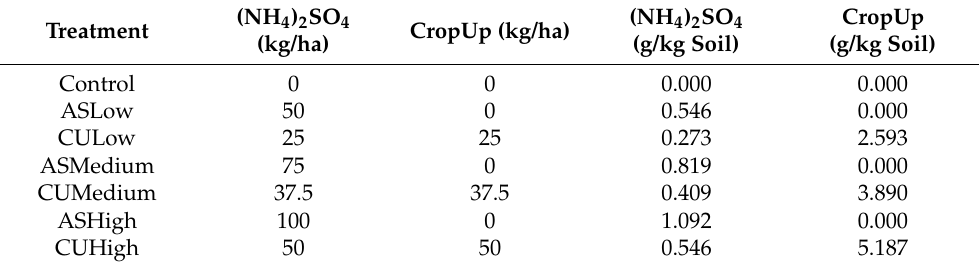
Table 2. Treatments used in the rainfall simulation experiment. “AS” indicates inorganic N source (NH 4 ) 2 SO 4 and “CU” indicates combined (NH 4 ) 2 SO 4 + CropUp TM .